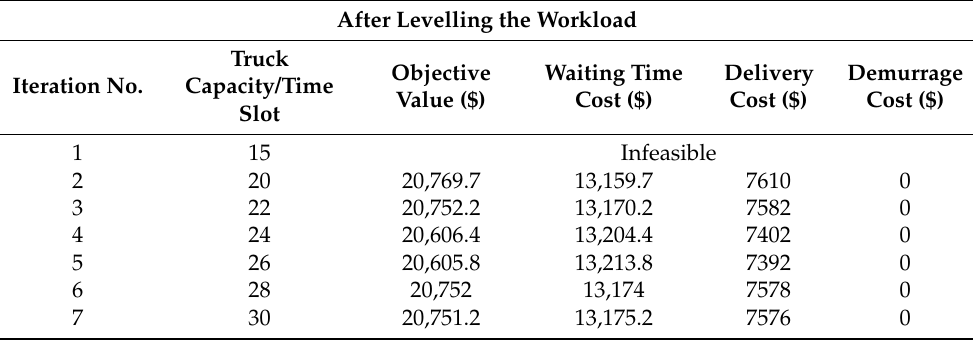
Table 13. The objective values and other cost terms after balancing the workload level. After Levelling the Workload Iteration